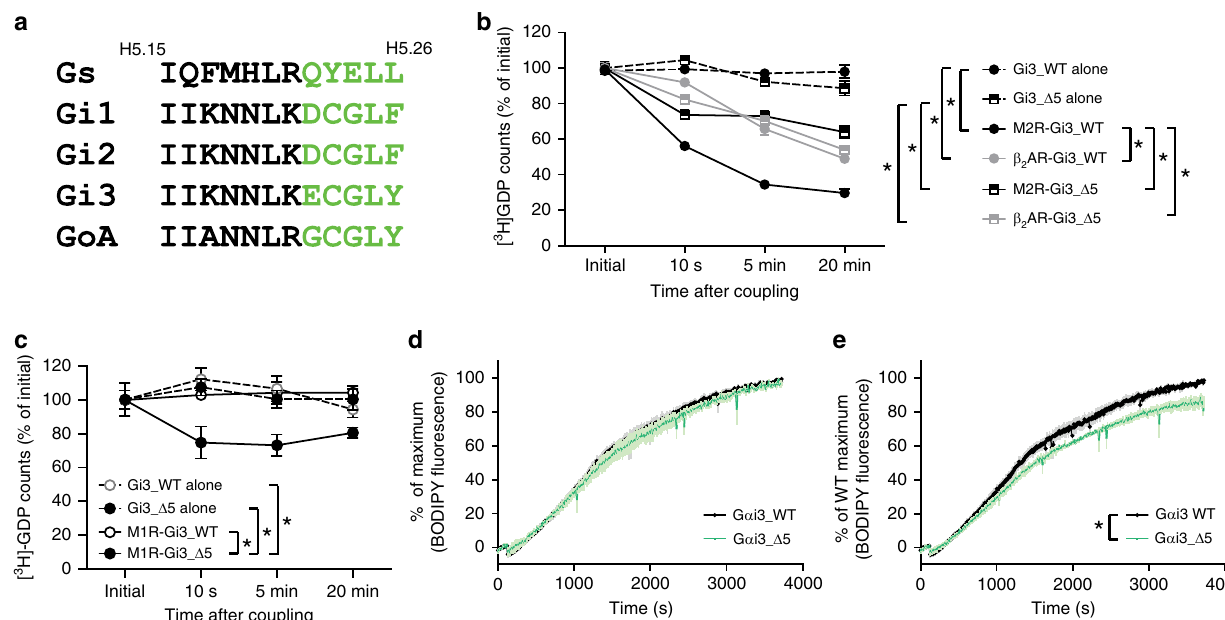
Fig. 3 The role of G α i3 wavy hook in primary and secondary Gi coupling. a Sequence alignment of the C-terminal part of G α s and G α i/o proteins. b GDP release pro fi les of Gi3_WT and Gi3_ Δ 5 induced by the M2R or the β 2 AR. c GDP release pro fi les of Gi3_WT and Gi3_ Δ 5 induced by the M1R. For ( b ) and ( c ), * indicates statistical differences between groups analyzed by one-way ANOVA test ( p < 0.05). Error bars represent mean ± S.E.M of at least three independent experiments ( n = 3 – 6). d BODIPY fl uorescence presented as percent (%) of maximum of each sample. e BODIPY fl uorescence represented as percent (%) of WT G α i3 maximum. Error bars (gray for WT G α i3 and light green for G α i3_ Δ 5) represent mean ± S.E.M of three independent experiments. * Indicates statistical differences between groups analyzed by a two-tailed Student ’ s t test ( p < 0.05). Source data are provided as a Source data fi